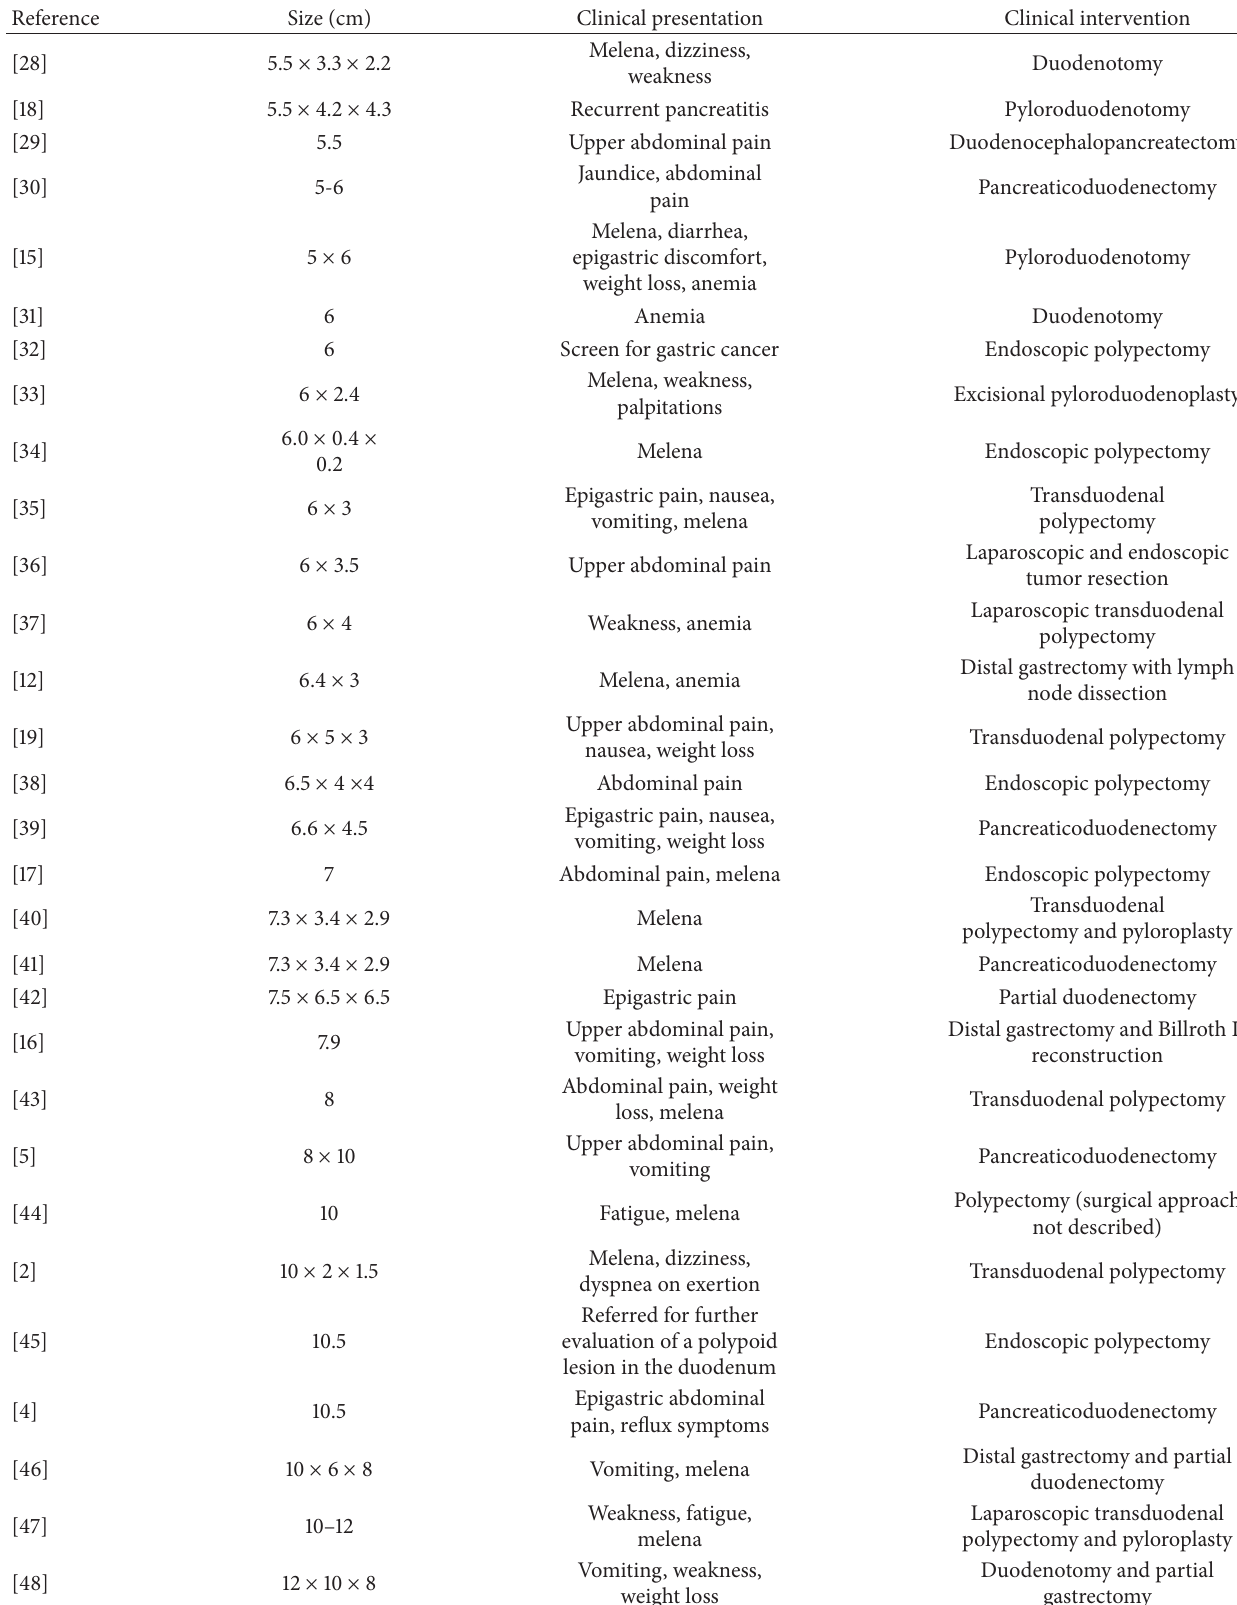
Table 1: Reported cases of Brunner’s gland hamartomas larger than 5 cm and concomitant interventional